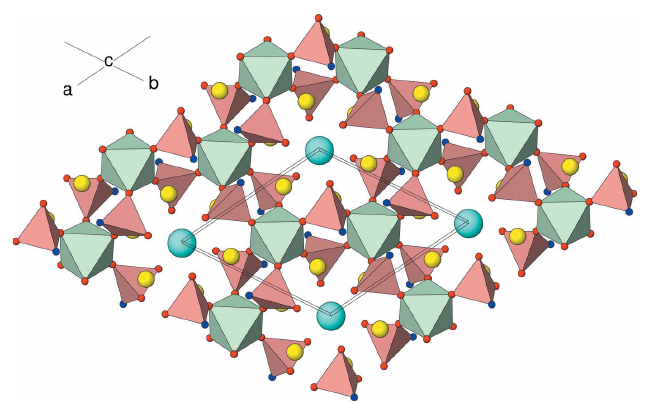
Figure 3 View down [001] of an ‘A’-type layer in the structure of (I) in polyhedral representation. Atom and polyhedron colours as in Fig. 2 except O3 is blue. The As1 atom in (I) is surrounded by four oxygen atoms (O1–O4) in the geometry of a slightly distorted tetrahedron [mean As—O = 1.677 A˚ , spread of O—As—O angles = 103.0 (2)–114.9 (2) (cid:3) , (cid:5) (Yang et al. , 2007) = 0.95]. Atom As2 is 4 also tetrahedral (to 2 (cid:4) O5 and 2 (cid:4) O6), with the latter O atom disordered over two adjacent sites in almost equal occupancies of 0.45 (3):0.55 (3) [O6 A (cid:6) (cid:6) (cid:6) O6 B = 0.909 (13) A˚ ]. Of the six oxygen atoms in the structure of (I), four of them (O2–O5) bridge zirconium and arsenic atoms with a mean Zr—O—As bond angle of 141.5 (cid:3) [equivalent mean Hf—O— As bond angle in (II) = 140.4 (cid:3) ] and two (O1 and O6) are ‘terminal’ and only bonded to arsenic: all of the O atoms also